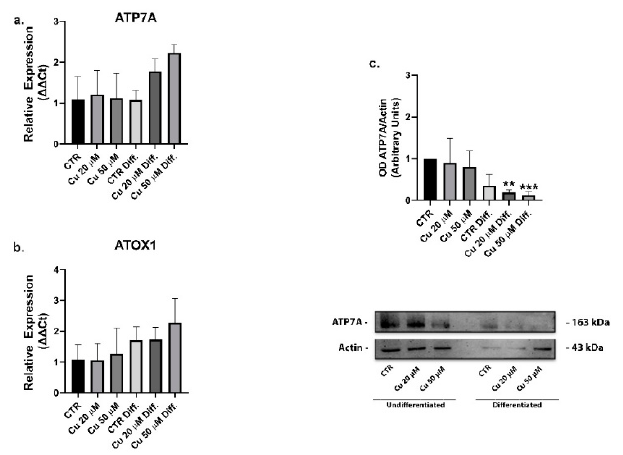
Figure 7. Copper treatment did not change the expression of the chaperone Atox1 and ATP7A transporter. mRNA relative expression of the transporter ATP7A ( a ) and Atox1 chaperone ( b ) in undifferentiated and differentiated cells incubated with 20 or 50 µ M copper. Representative immunoblots of the ATP7A protein and densitometric analysis of bands representing means ± SD of three independent experiments ( c ). β -actin was used as loading control. Values were compared with untreated cells (CTR) by one-way ANOVA following Tukey test ** p < 0.0021 *** p < 0.0002.